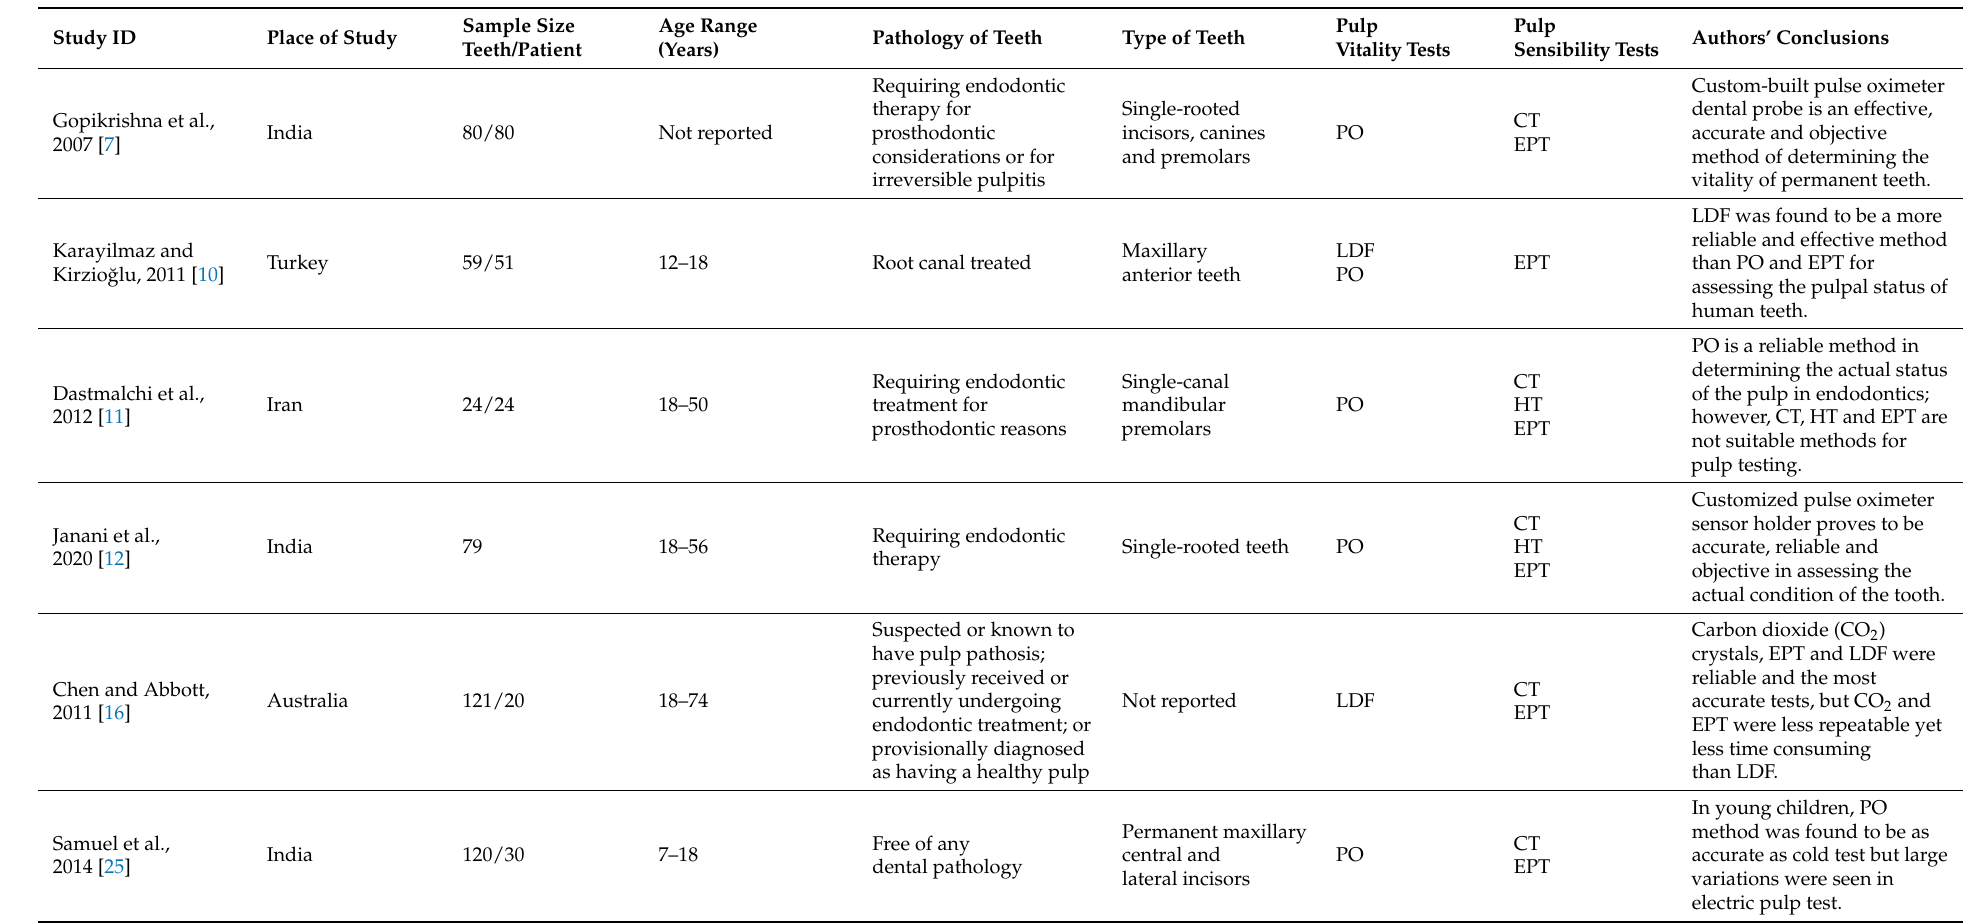
Table 2. Study characteristics of included